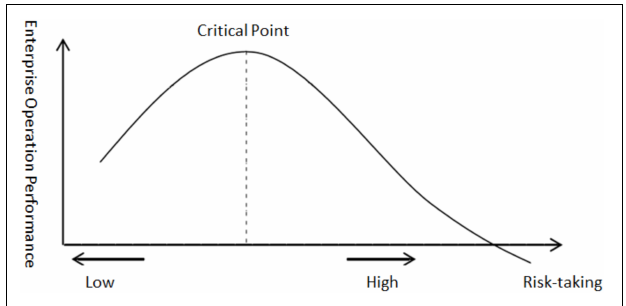
FIGURE 1 | The relationship between entrepreneurial risk-taking and business